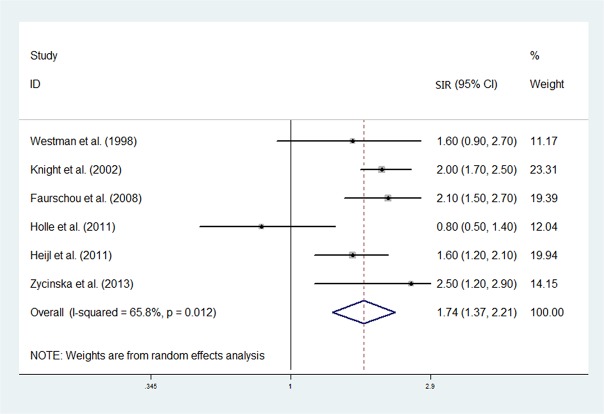
Forest plot of association between ANCA-associated vasculitis (AASV) and overall cancer.